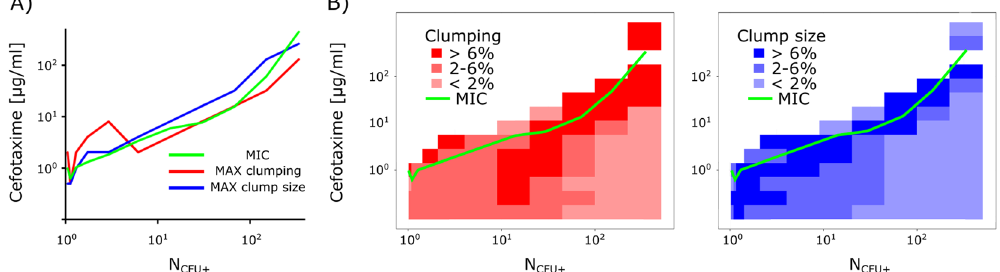
Figure 4. Cefotaxime modulates the clumping of bacteria. ( A ) At various inoculum densities, both the highest clumping (red) and the greatest size of clumps (blue) occur near sub-inhibitory cefotaxime conditions (green). ( B ) Heat maps of relative clumping rates (red) and relative clump sizes (blue)) in the matrix of different bacteria densities (X-axis) and cefotaxime concentrations (Y-axis). Green line shows the approximate MIC in these experiments (same data as on Fig.